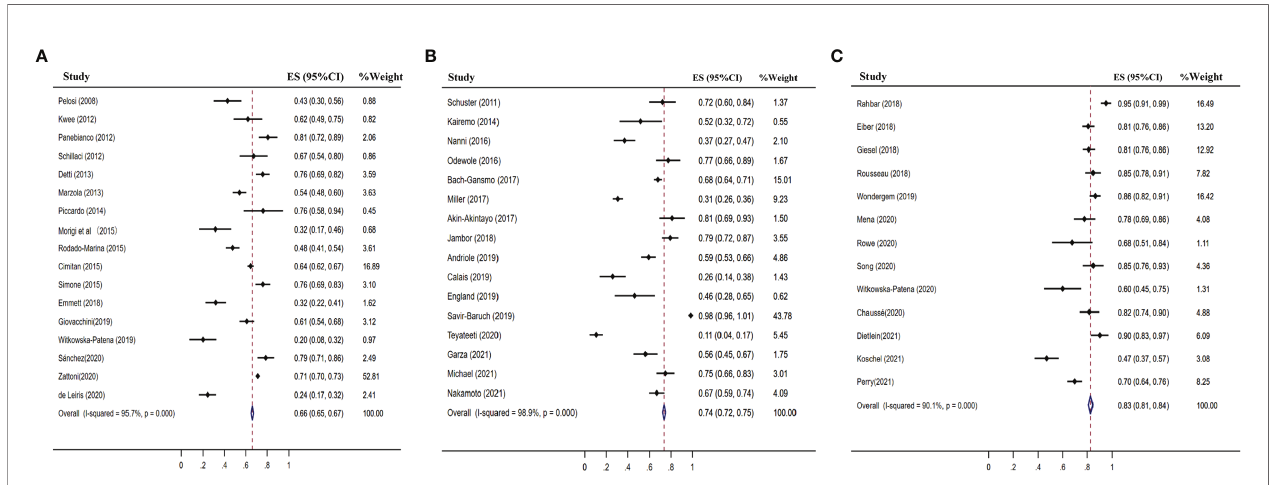
FIGURE 6 | Forest plot of the proportion of 18 F-labeled choline (A) , fl uciclovine (B) and PSMA (C) PET/CT positivity of prostate cancer patients with biochemical recurrence.